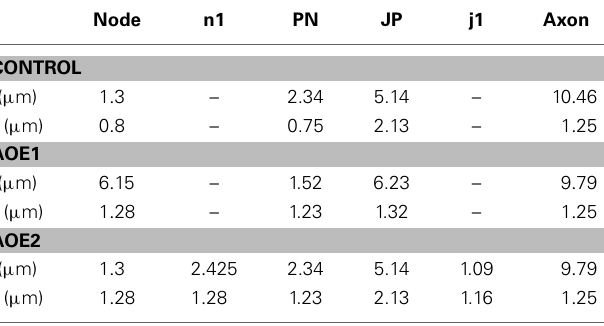
Table 1 | Morphological parameters of the auditory nerve in control and in the two simulated AOE conditions.